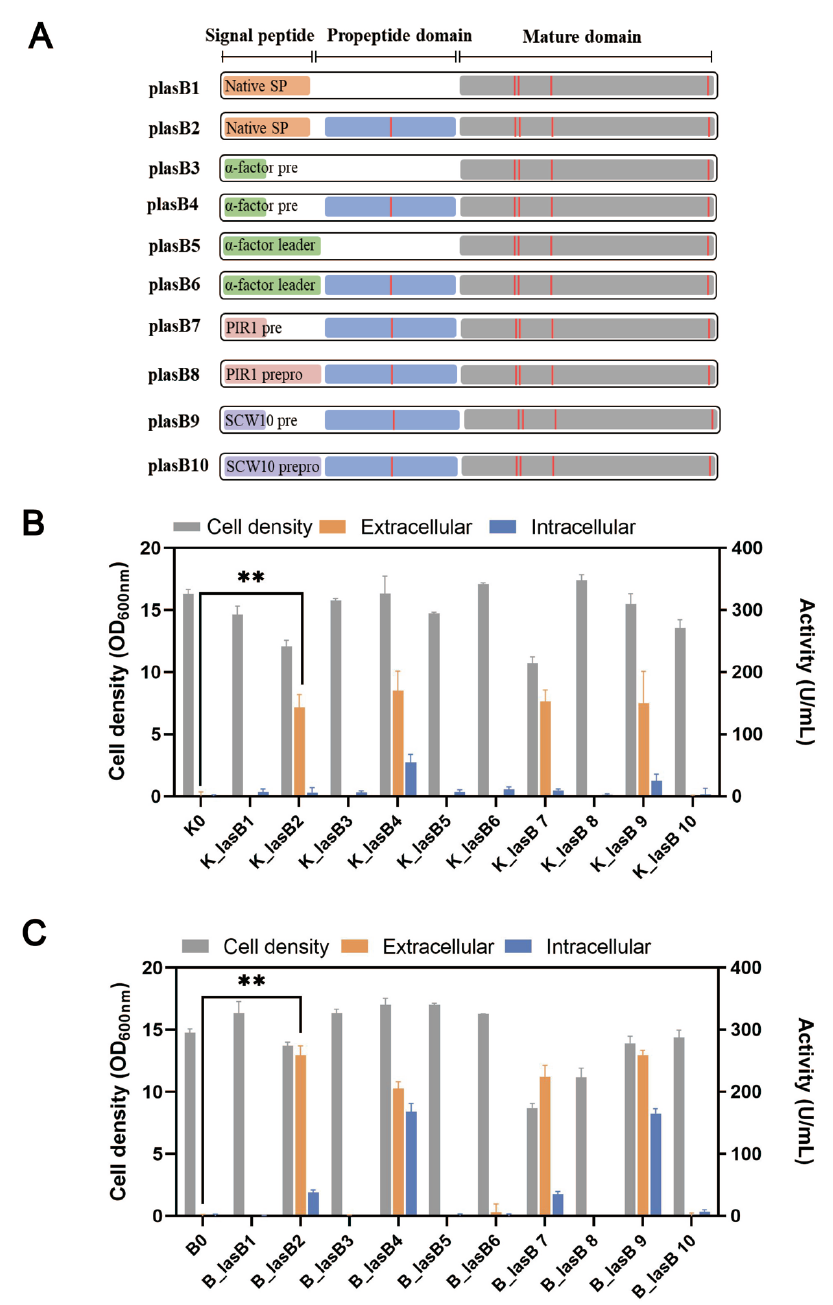
Figure 2. The protease production in CEN.PK 530-1C and B184M with different expression cassettes. ( A ) Pseudolysin expression cassette. Orange bar: native signal peptide of pseudolysin; short green bar: pre-region of α -factor leader; long green bar: complete α -factor leader; short grey pink bar: pre-region of PIR1 signal leader; long grey pink bar: complete PIR1 signal leader; short light purple bar: pre-region of SCW10 signal leader; long light purple bar: complete SCW10 signal leader; blue bar: propeptide of pseudolysin; gray bar: mature domain of pseudolysin; red vertical lines: five mutation sites found in mutant pseudolysin. ( B ) Cell density and proteolytic activity of S. cerevisiae strain CEN.PK 530-1C with different pseudolysin expression cassettes. ( C ) Cell density and proteolytic activity of S. cerevisiae strain B184M with different pseudolysin expression cassettes. ** p < 0.01.